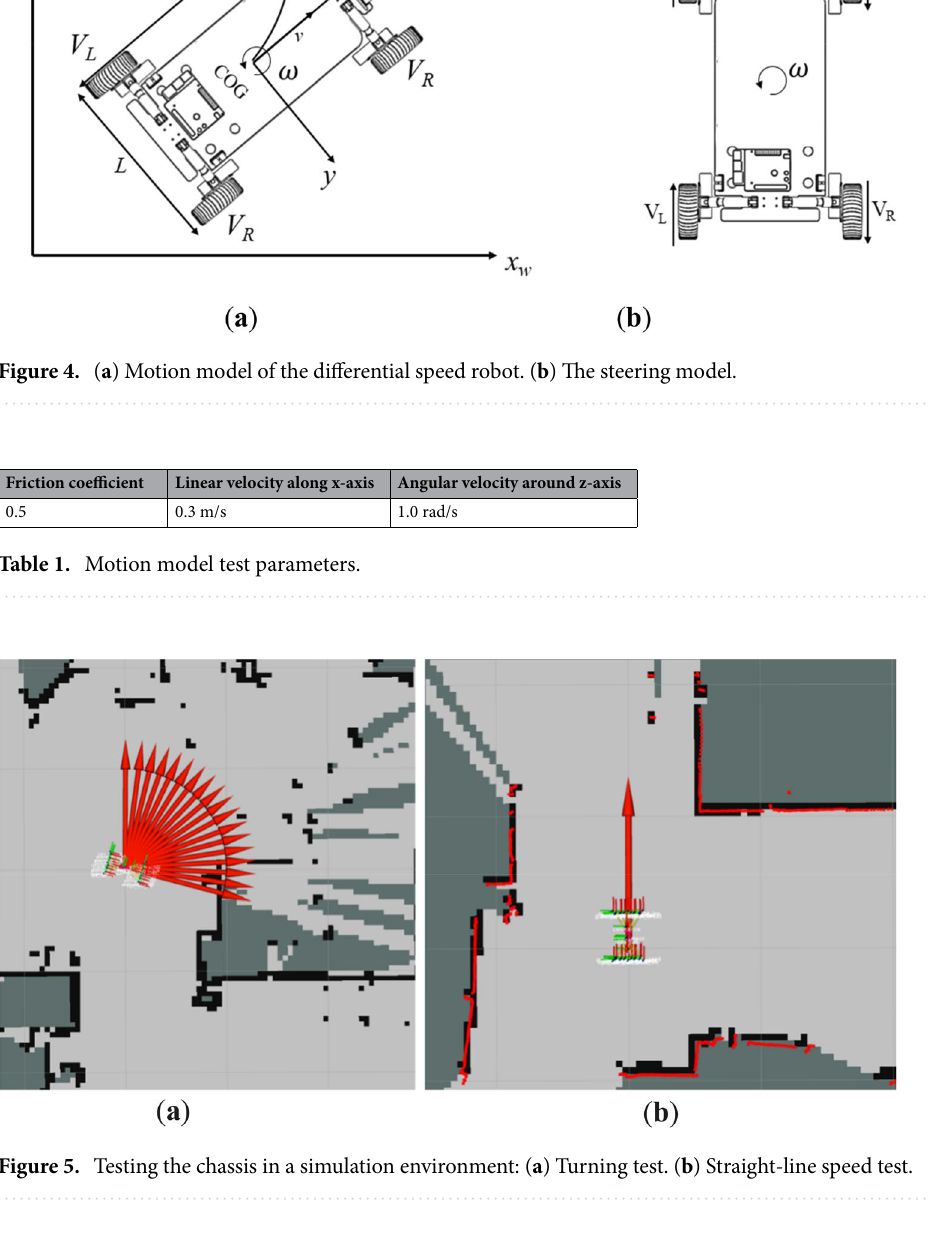
the turn increases when the speed difference between the left and right wheels is larger. When the robot works in a narrow space, the robot turns around its middle vertical axis, i.e., the left and right wheels have the same speed but in opposite directions, and the turning radius is 0. The performance of key parts of the robot needs to be analyzed using specialized software before it is actually applied in order to avoid unnecessary waste of time and money 17 . In order to investigate the slippage problem of the above motion model, the simulation is carried out in gazebo. The dynamic tag is added to the tire link tag and the ground link tag in the XACRO file of the robot model. A dynamic tag is to add to measure the friction coefficient between the tire and the ground. The parameters are shown in Table 1. Figure 5a shows the rotation speed of the inspection robot around its own central axis. Figure 5b shows the speed test of the inspection robot walking a straight line. Through the simulation, it is found that the motion model can complete going straight and rotating, while the occurrence of slippage is relatively mild.